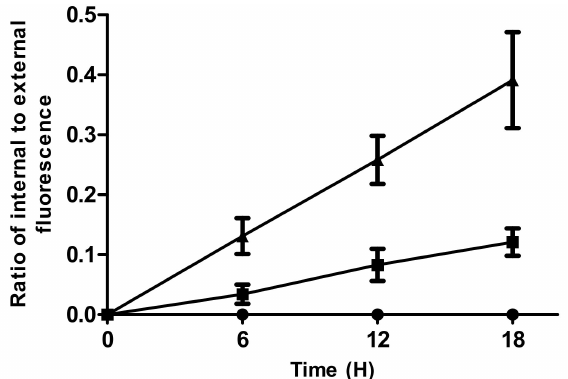
Figure 3. Diffusion properties of the Si-HPMC particles. Particles of Si-HPMC were incubated